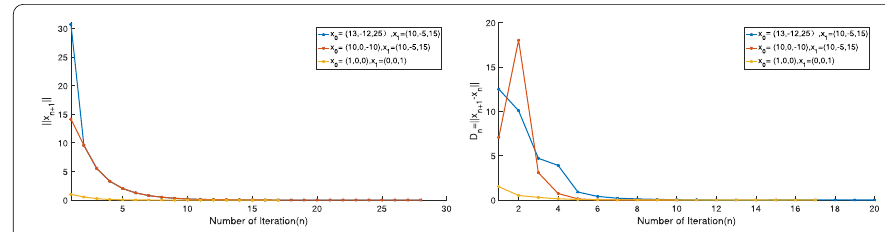
Figure 2 Results of Algorithms 3.1 and 3.2 for different initial points in Example 5.2